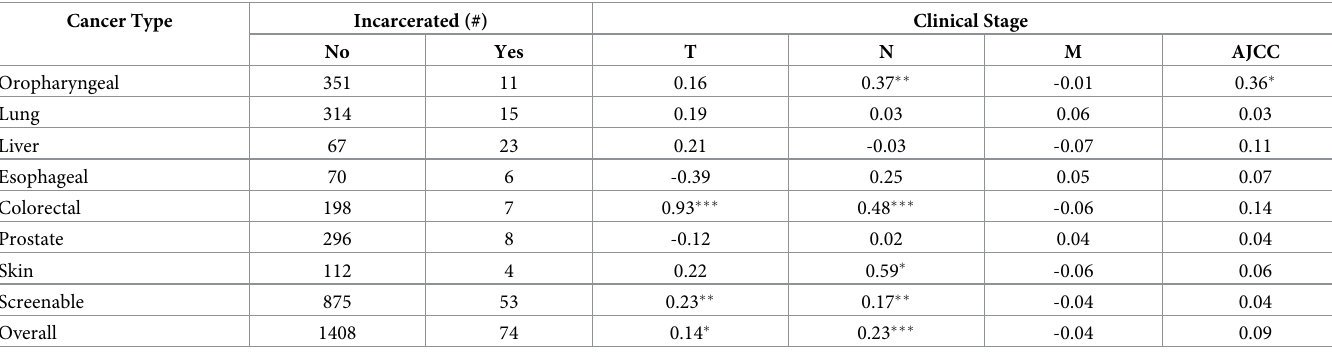
Patients who are incarcerated experience an increased mortality due to cancer, however the mechanism behind this has remained unclear. Our findings comport with previous research, Table 3. Adjusted regression results for the effects of incarceration status on initial cancer staging, by cancer subtype. Cancer